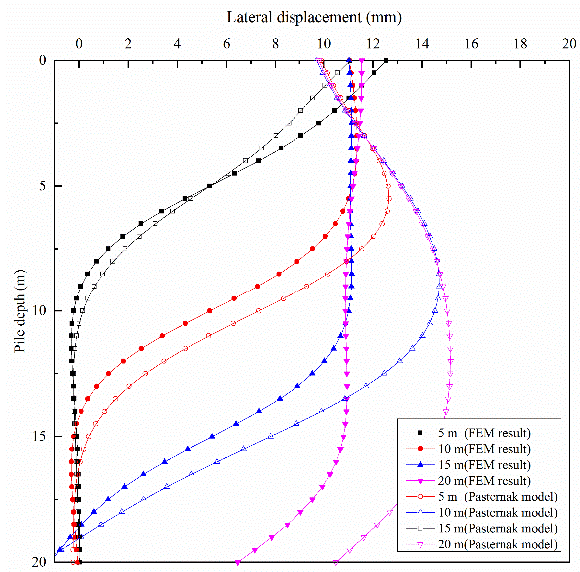
Figure 11. Comparison of calculation results between numerical simulation and Pasternak foundation model with pile tip free.